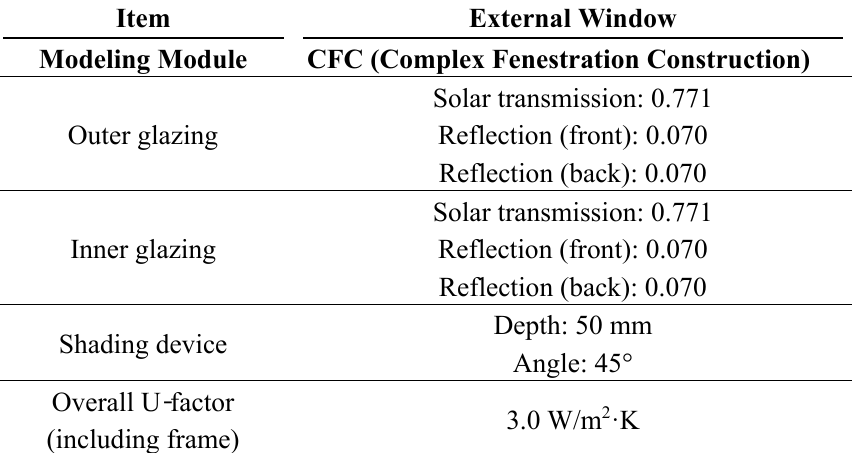
Table 3. Properties of the